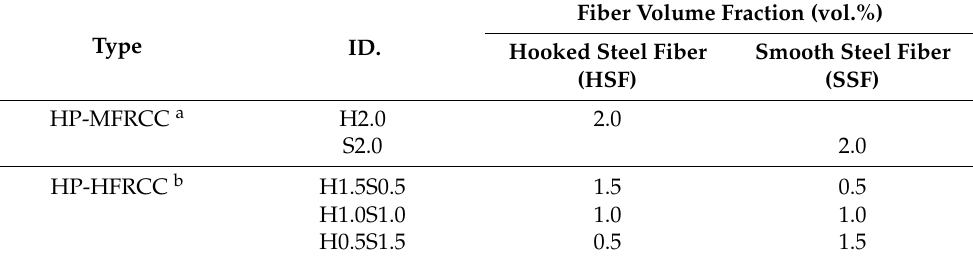
Table 1. Series of test specimens.